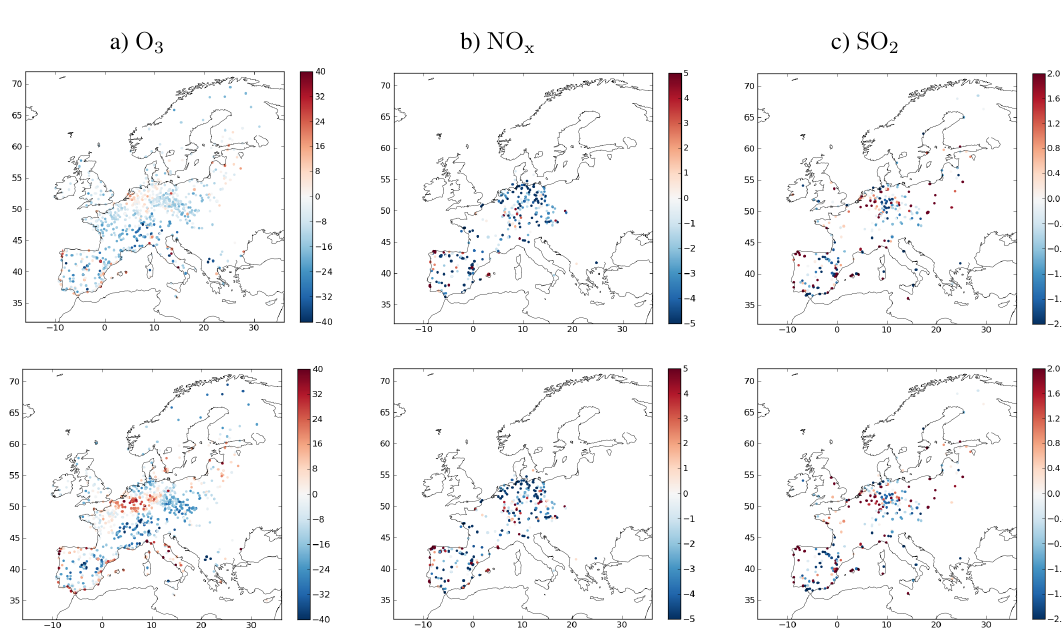
Fig. 11. Spatial distribution of mean bias (µg m − 3 ) for daily M × 8h O 3 (a) , daily mean NO x (b) and daily mean SO 2 (c) concentrations for the average summertime period of 2004–2008. The two rows represent ANALY (top) and CLIM (bottom). Table 6, for ANALY, annual correlations of hourly values and daily M × 8h O 3 concentrations reach 0.61 and 0.7, re- spectively. Also, annual and seasonal MNB values for hourly and daily M × 8h O 3 show good performance in accordance with the recommendation of US-EPA (MNBE ≤ ± 15